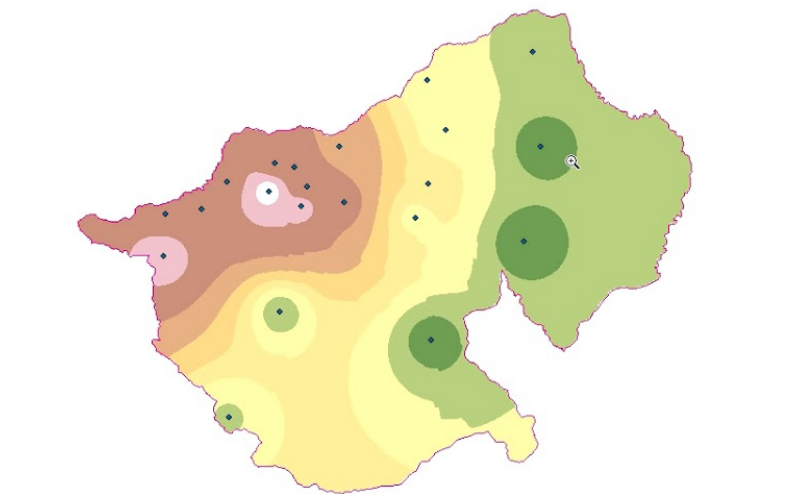
Figure 8. An example interpolation (adapted from